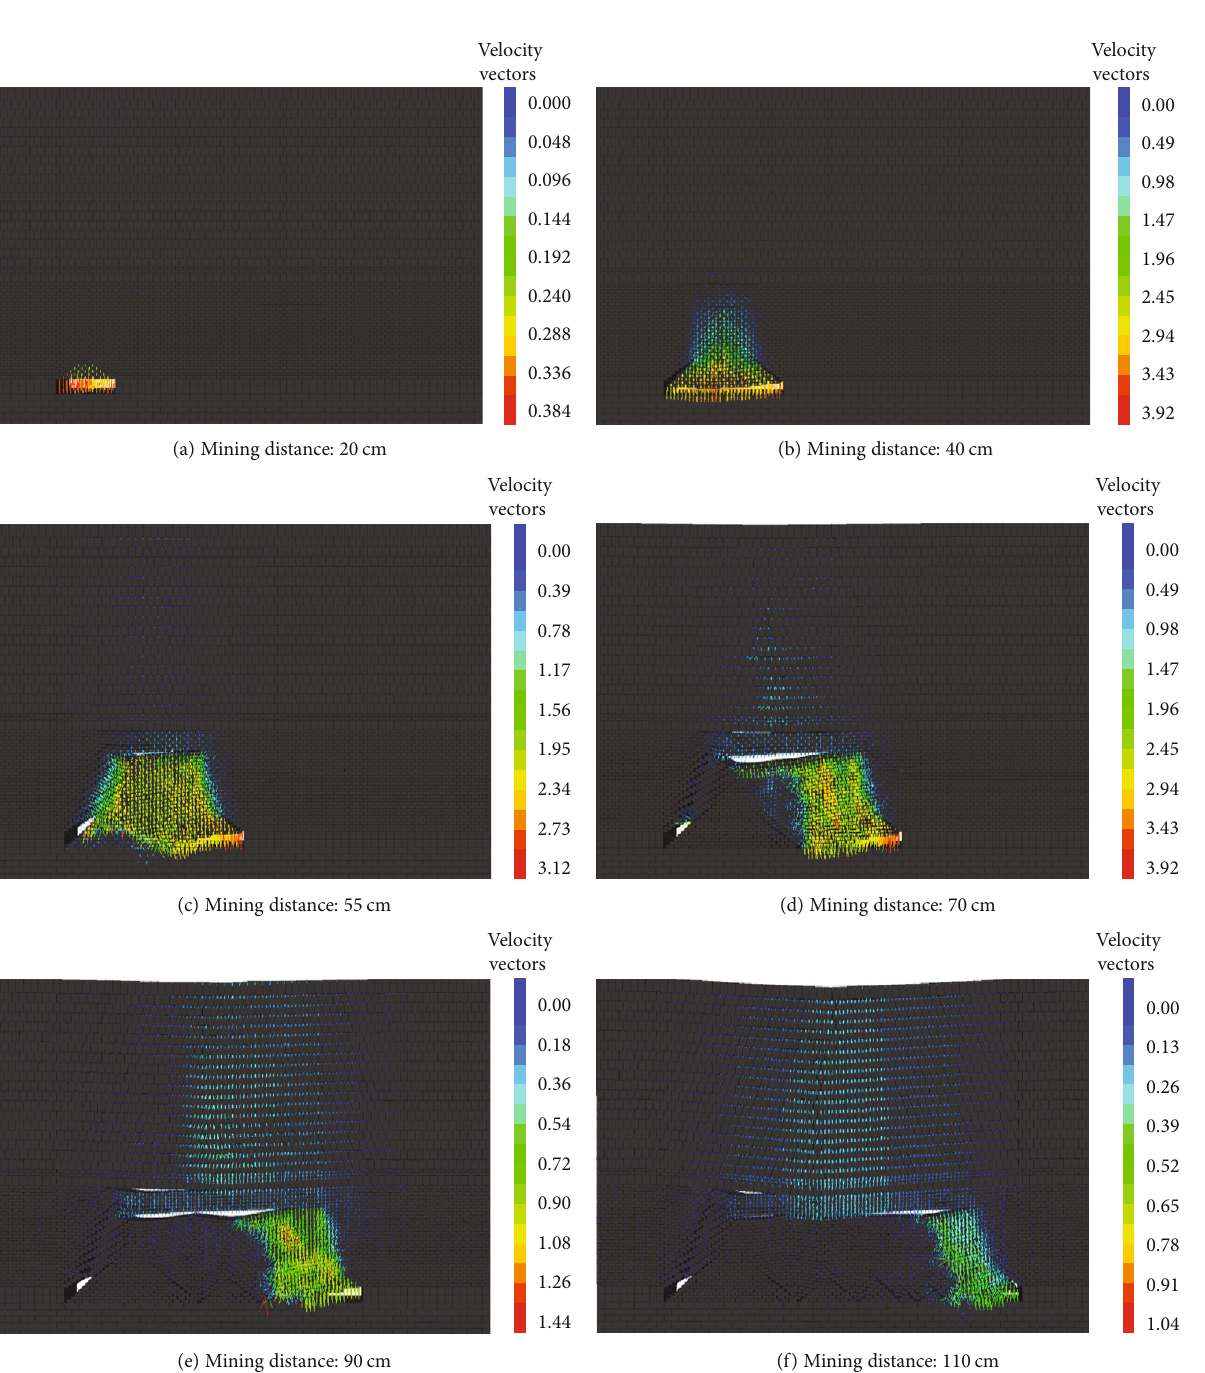
Figure 10: Velocity vector variation of the roof during the advancement of the mining